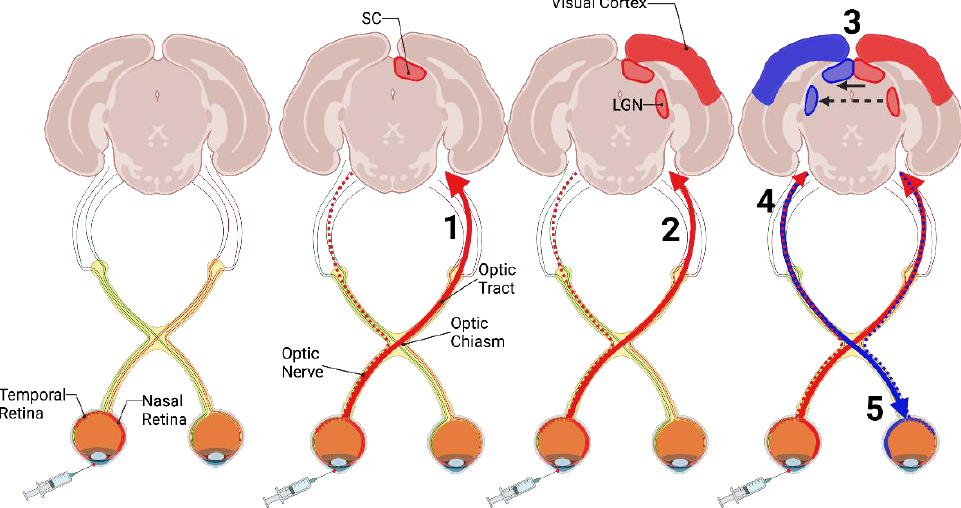
Figure 1. Prion spread following intraocular inoculation. Inoculation of prions into the retina of rodents results in anterograde spread of prion agent from the inoculated retina to the contralateral superior colliculus (SC; 1) and lateral geniculate nucleus (LGN), and visual cortex (solid red line and red structures; 2). As the animal approaches clinical endpoint, the ipsilateral SC, LGN, and visual cortex are also affected to a lesser extent (blue structures). This is thought to be due to reciprocal connections between the contralateral SC (solid black arrow; 3) and LGN (dashed black arrow; 3) and ipsilateral anterograde spread from the inoculated retina (dashed red line; 4). The uninoculated optic nerve and retina are also affected through retrograde prion spread (solid blue line; 5). Image created with BioRender.com, accessed on 28 February 2022.